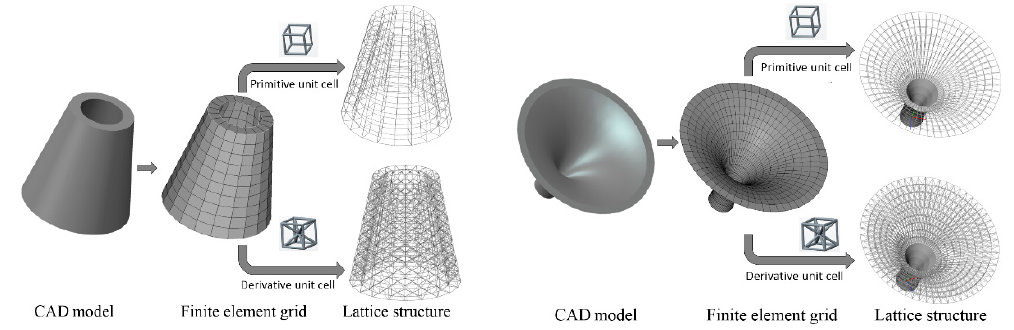
Figure 3. Illustrations of lattice generation for given geometries.